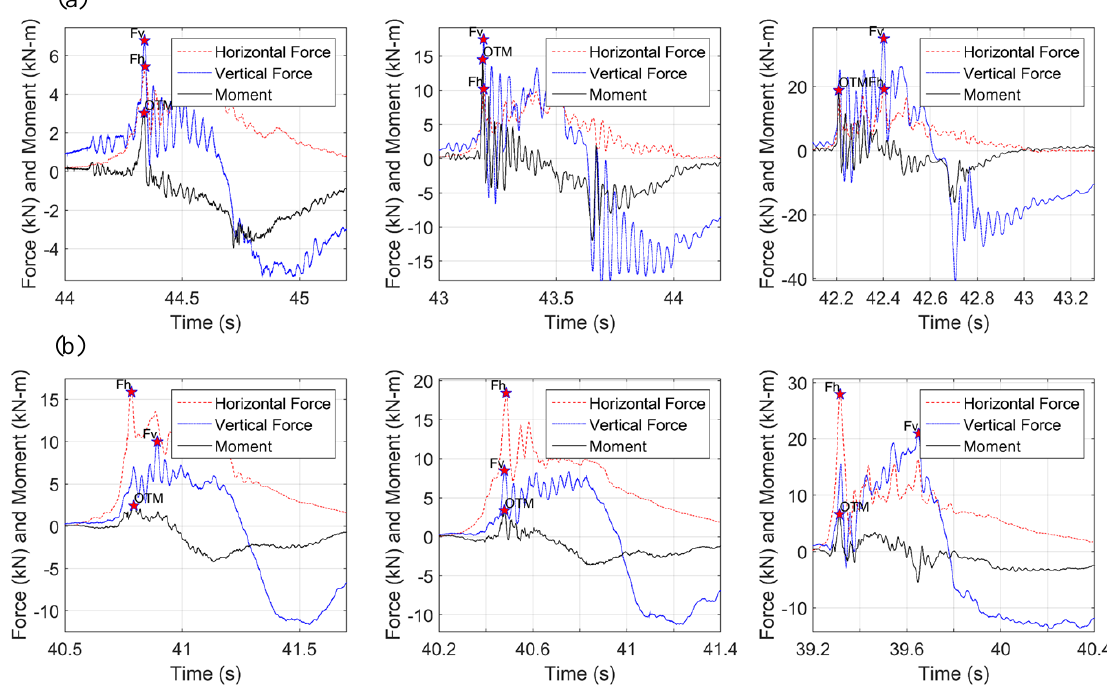
Figure 13. Total horizontal forces and moment for ( a ) solitary waves (top) with H = 0.42 m (left), H = 0.55 m (center) and H = 0.70 m (right), and ( b ) bores (bottom) with H = 1.0 m (left), H = 1.10 m (center) and H = 1.40 m (right).